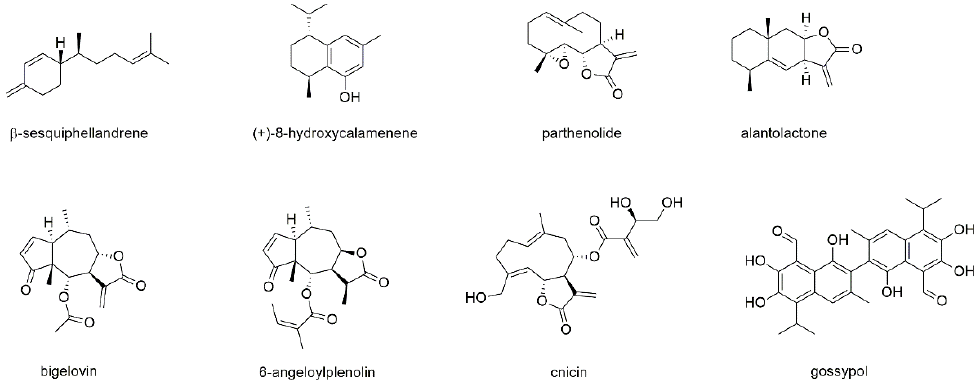
Figure 11. Sesquiterpenes with reported activity against myeloma cell